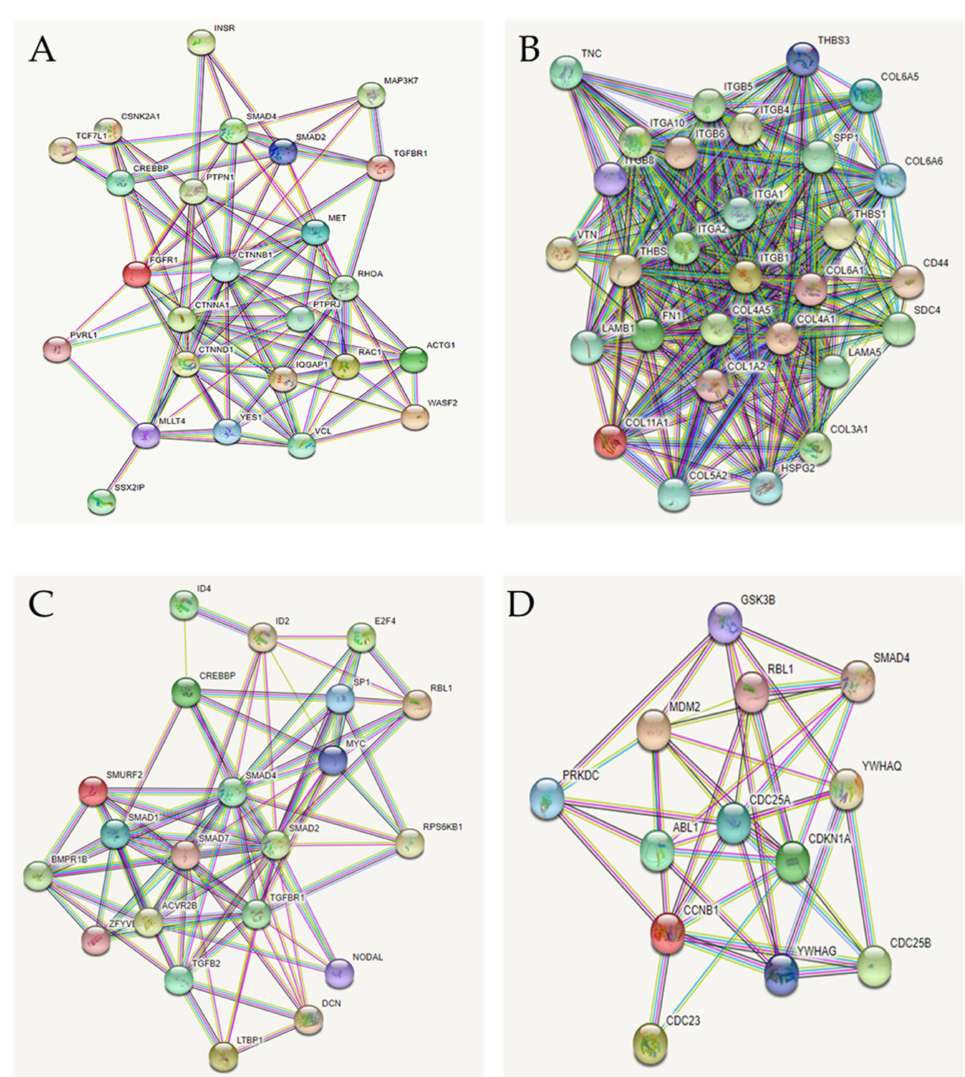
Figure 5. Protein − protein interaction (PPI) network. PPI network has been generated by STRING (Search Tool for the Retrieval of Interacting Genes/Proteins) based on the targeted proteins involved in ( A ) the adherens junction; ( B ) the ECM-receptor interaction pathway; ( C ) the TGF β ; and ( D ) the cell cycle pathway. Nodes are proteins. The thickness of the line is proportional to the strength of the interaction between 2